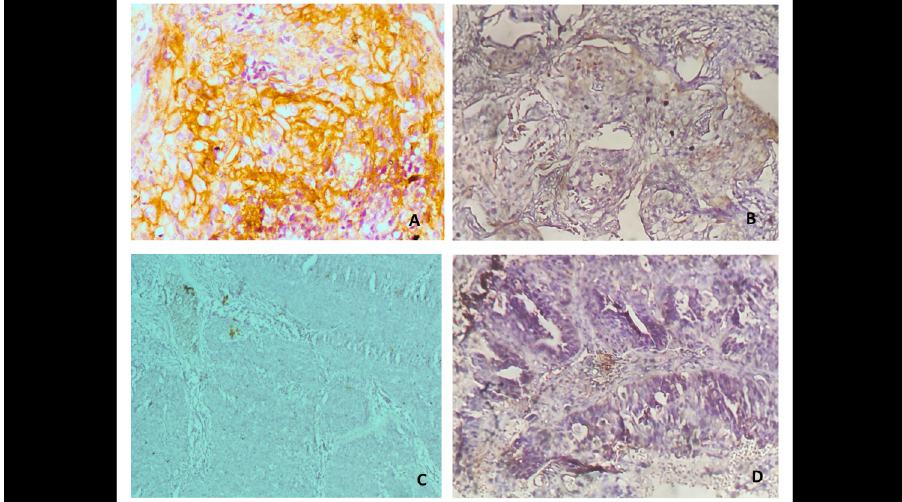
Fig 3. (a) Photomicrograph showing diffuse staining in a large cell keratinizing squamous cell carcinoma (anti-PD-L1 immunohistochemical stain, X400) (b) weak and partial membranous staining (anti-PD-L1 immunohistochemical stain, X200) (c) Negative PD-L1 staining (d) PD-L1 positive adenocarcinoma (anti-PD-L1 immunohistochemical stain, X200).